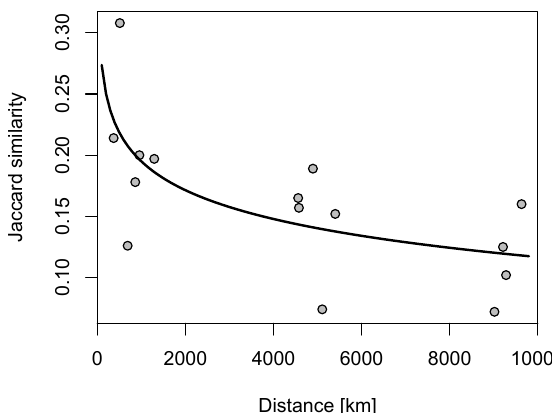
Figure 3. Distance-decay in similarity of nematode lake communities. Nematode community composition of each lake was compared with each other (Jaccard index) and related to their distance (in km). Distant lakes are less similar inter se, corroborating data of fig. 2 (see fig. 2 for names of lakes; Baikal was excluded owing to its peculiar nematocoenosis). The decline in similarity with distance is visualised using linear regression of Jaccard similarity with log-transformed distance values. A mantel test (R package ecodist version 2.0.1) revealed a significant (p < 0.05) decline in similarity with distance (r = -0.64).